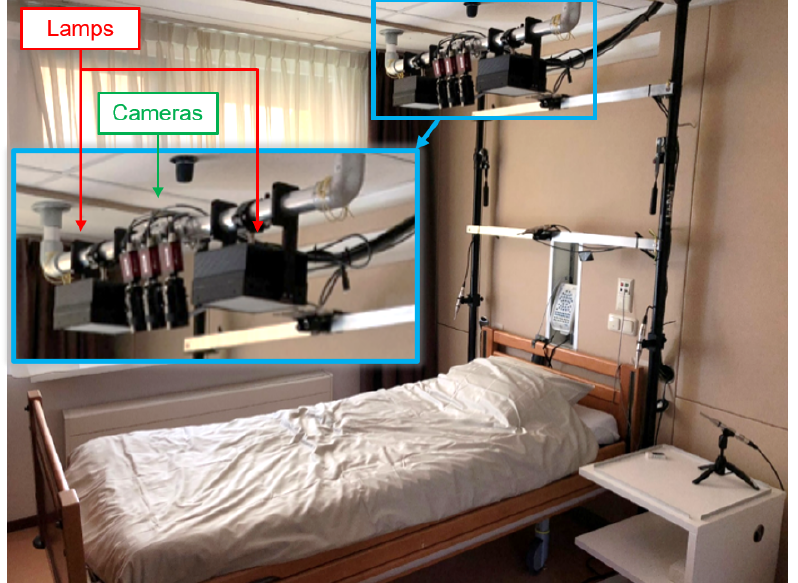
Figure 1. Measurement setup. Three cameras positioned between two illumination units were placed above the bed to continuously capture the patient’s face during the overnight